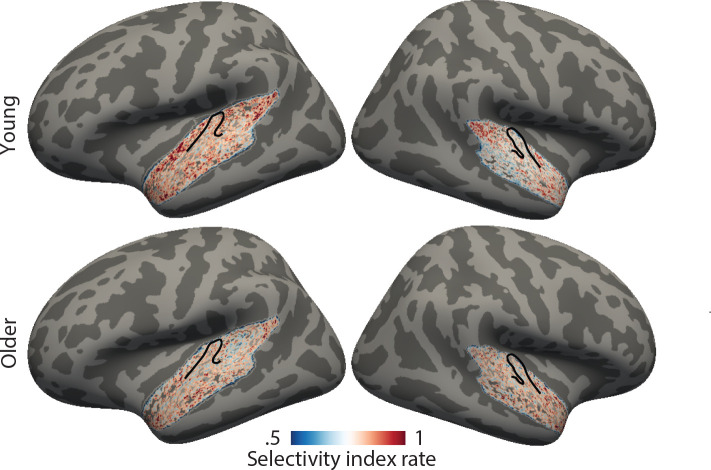
Topographic maps for the rate selectivity index.Maps were derived by calculating the SI across the rate profile for a given voxel and averaged in the young group (upper panel) and older group (bottom panel). Higher SI (red) indicates higher selectivity. Black outlines indicate Heschl’s gyrus.